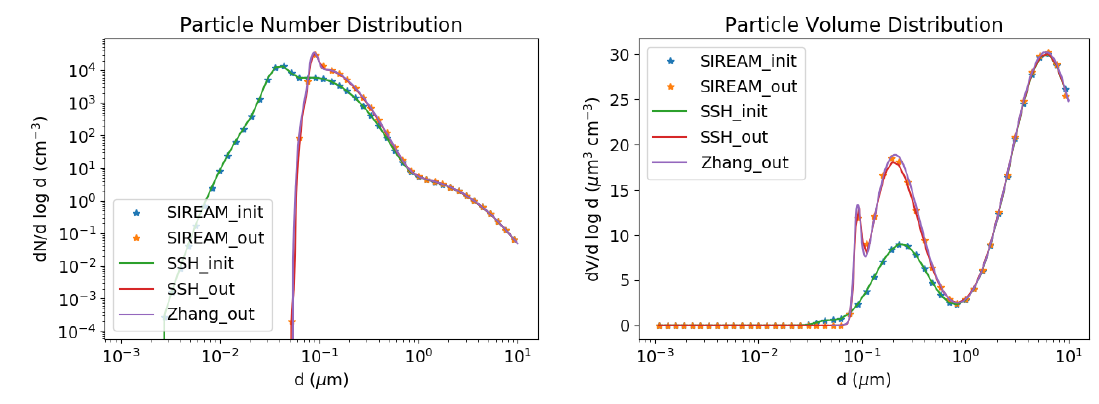
Figure 2. Condensation test case. Number ( left ) and volume ( right ) concentrations as a function of particle diameter. Initial concentrations are in green and concentrations after 12 h of simulation are in red. The concentrations simulated with SIREAM are plotted with orange stars and those simulated by Zhang et al. in